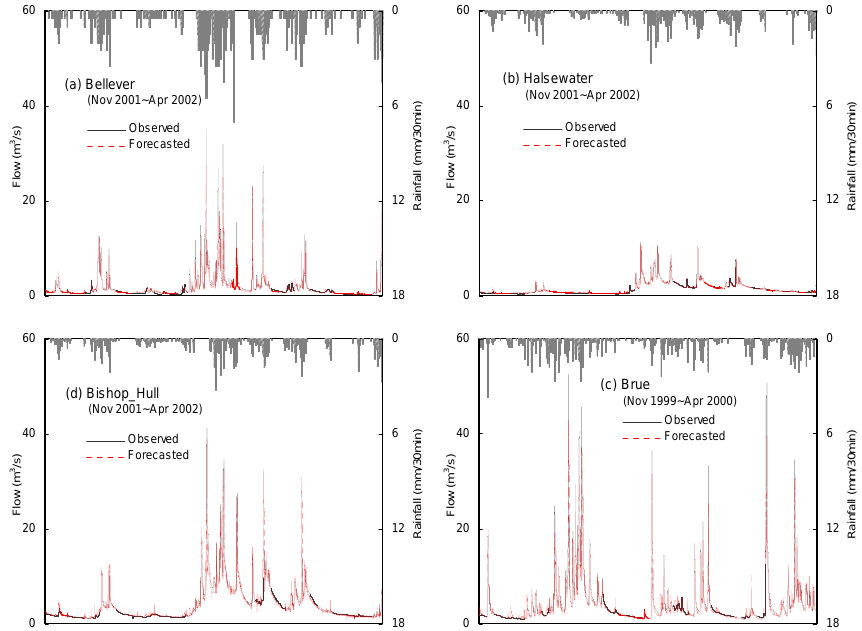
Figure 5 Six-month length hydrographs of the observed rainfall-runoff data versus the best results of the 4h-ahead forecasts using the 30 min data. The NSE values calculated between the observed and the forecasted flows are 0.8932, 0.9544, 0.9167 and 0.9420 respectively for the four catchments in subfigures (a), (b), (c) and (d).